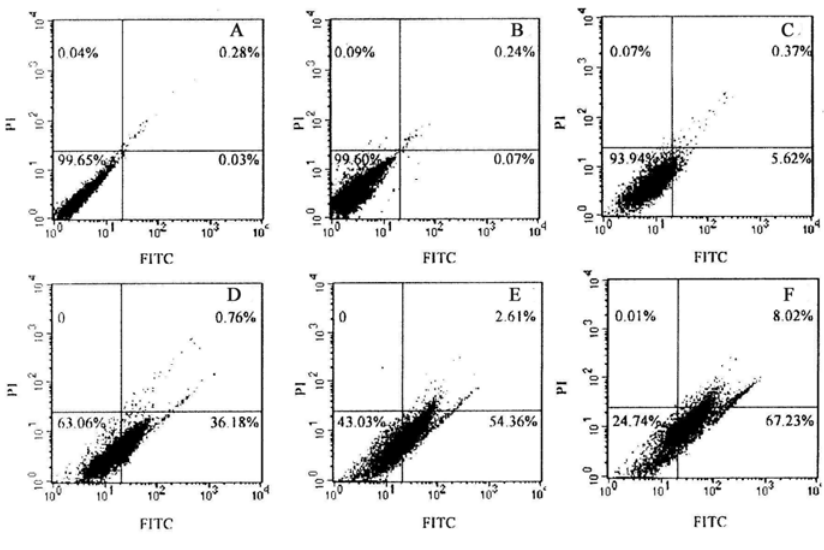
Figure 5. Effect of T α PcZn-PDT on the apoptosis of Bel-7402 cells assayed by flow cytometry analysis of Annexin V-FITC/PI double stained cells. Apoptosis assay in: panel A , control Bel-7402 cells treated with 0.1% DMSO; panel B , Bel-7402 cells treated with red-light irradiation (53.7 J/cm 2 ); panel C , Bel-7402 cells treated with 54 μ M T α PcZn; and panel D~F , Bel-7402 cells treated with 18, 36, 54 μ M T α PcZn in the presence of red-light irradiation(53.7 J/cm 2 ),